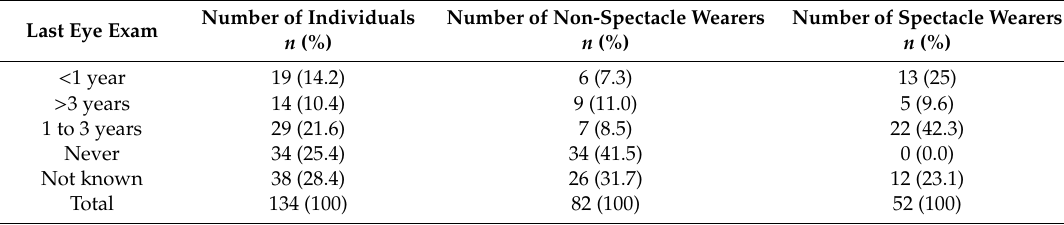
Table 2. Number of athletes attending an eye exam within a time interval. Athletes are classified according to whether they reported having spectacles (irrespective of whether they were wearing them for